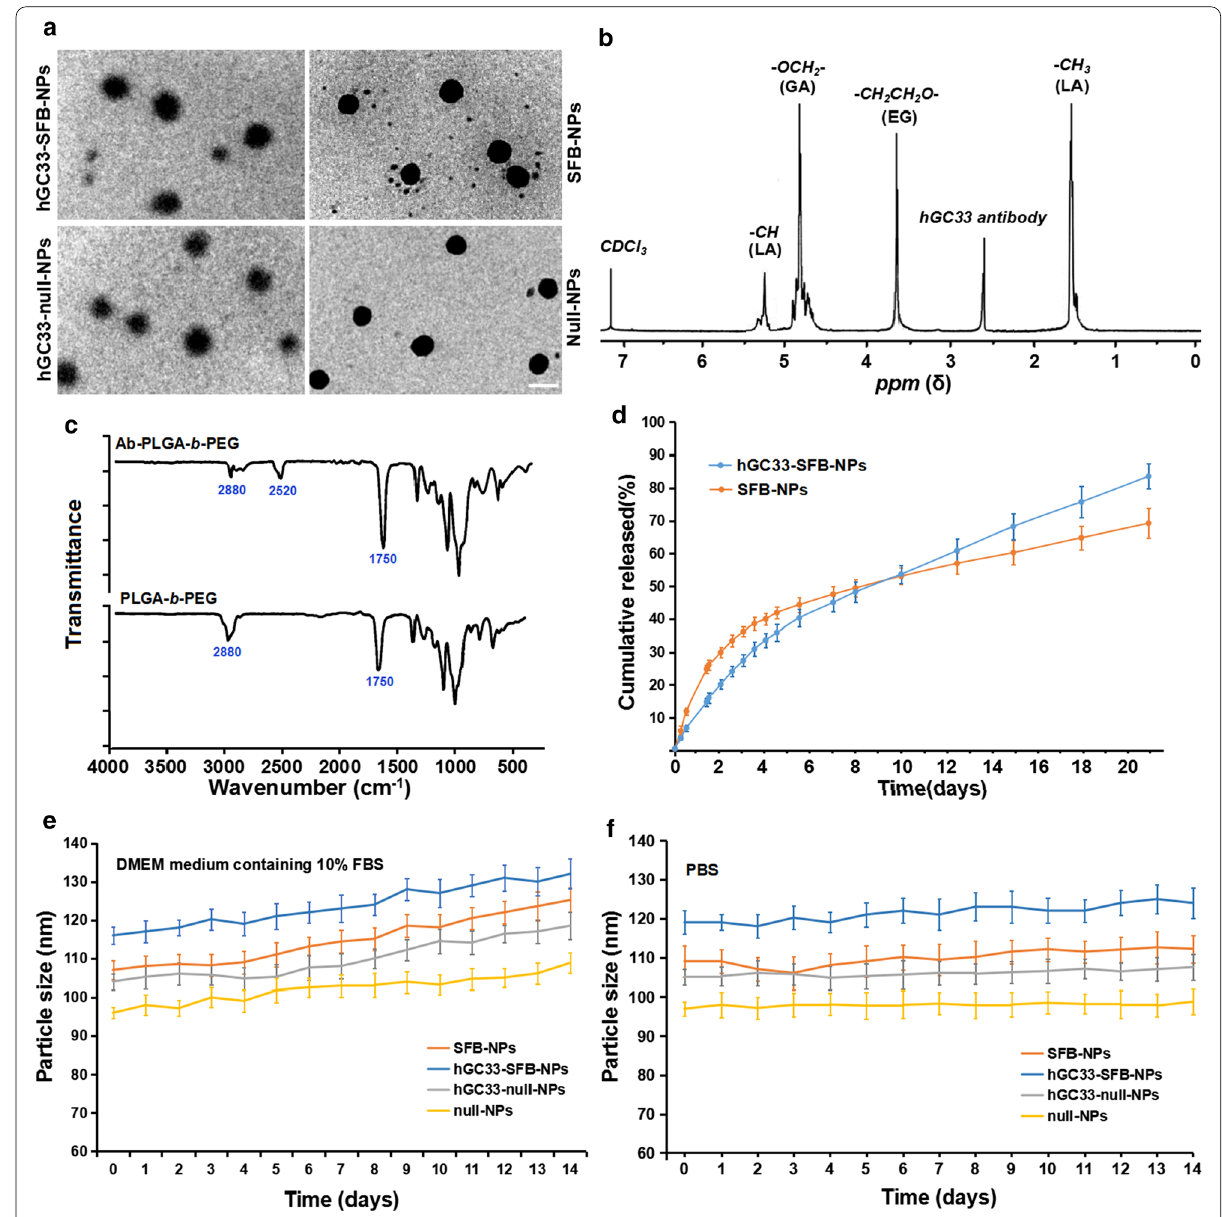
Fig. 1 Characterization of NPs. a TEM characterization of NPs, the scale bar indicates 100 nM; b the 1 H NMR spectra of synthetic hGC33-PLGA- b -PEG in CDCl3; c FTIR spectra of hGC33-PEG- b -PLGA and PEG- b - PLGA; d cumulative release profiles of SFB-NP and hGC33-SFB-NP in PBS (pH 37 °C; e size changes of NPs incubated in DMEM medium containing 10% FBS over 14 d; f size changes of NPs incubated in PBS over 14 d. SFB, sorafenib; TEM, transmission electron microscopy; NPs, nanoparticles; 1 H NMR, 1 H-nuclear magnetic resonance spectroscopy; FTIR, Fourier transform infrared